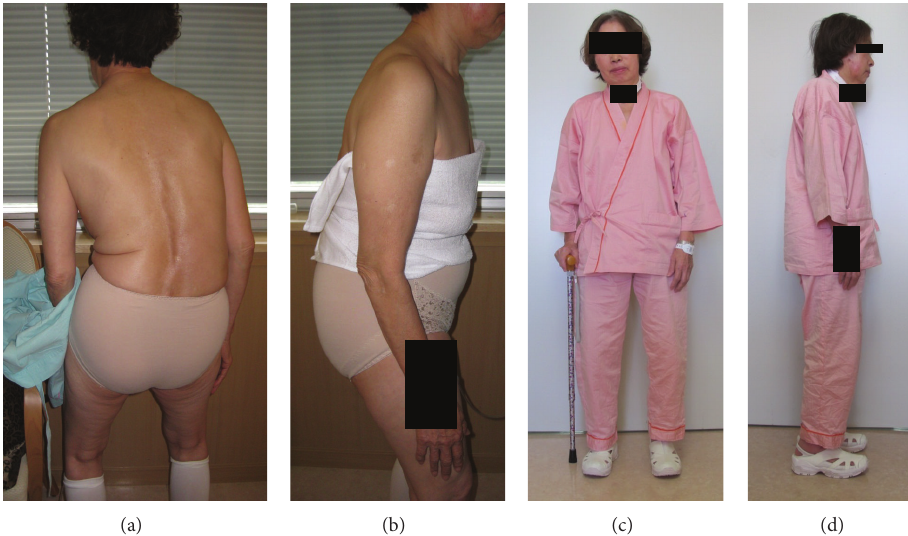
Figure 2: Posture before surgery and after surgery in Case 1. Posterior-anterior view (a) and lateral view (b) before surgery and anterior- posterior view (c) and lateral view (d) after surgery.